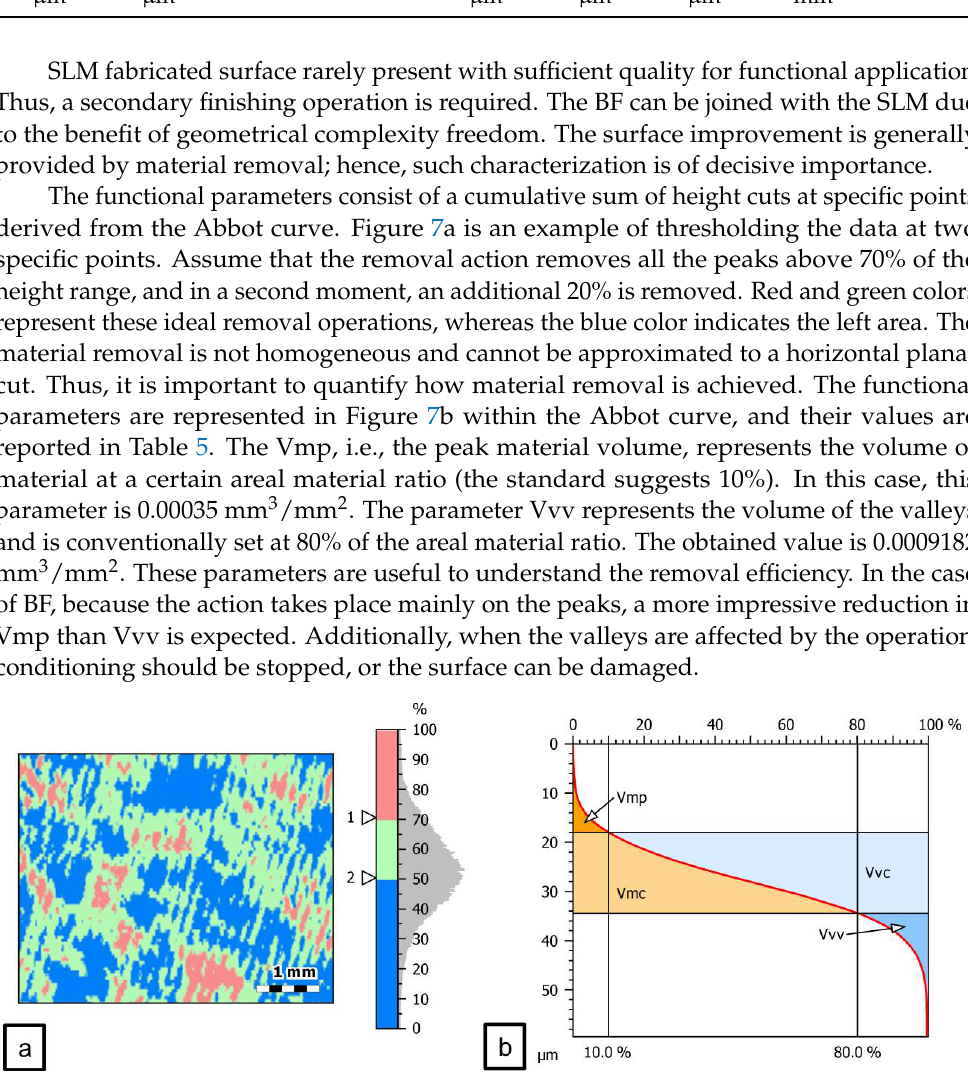
Figure 7. Threshold analysis ( a ) and volume parameters ( b ). Table 5. Functional parameters for the 0° slope surface. Table 5. Functional parameters for the 0 ◦ slope